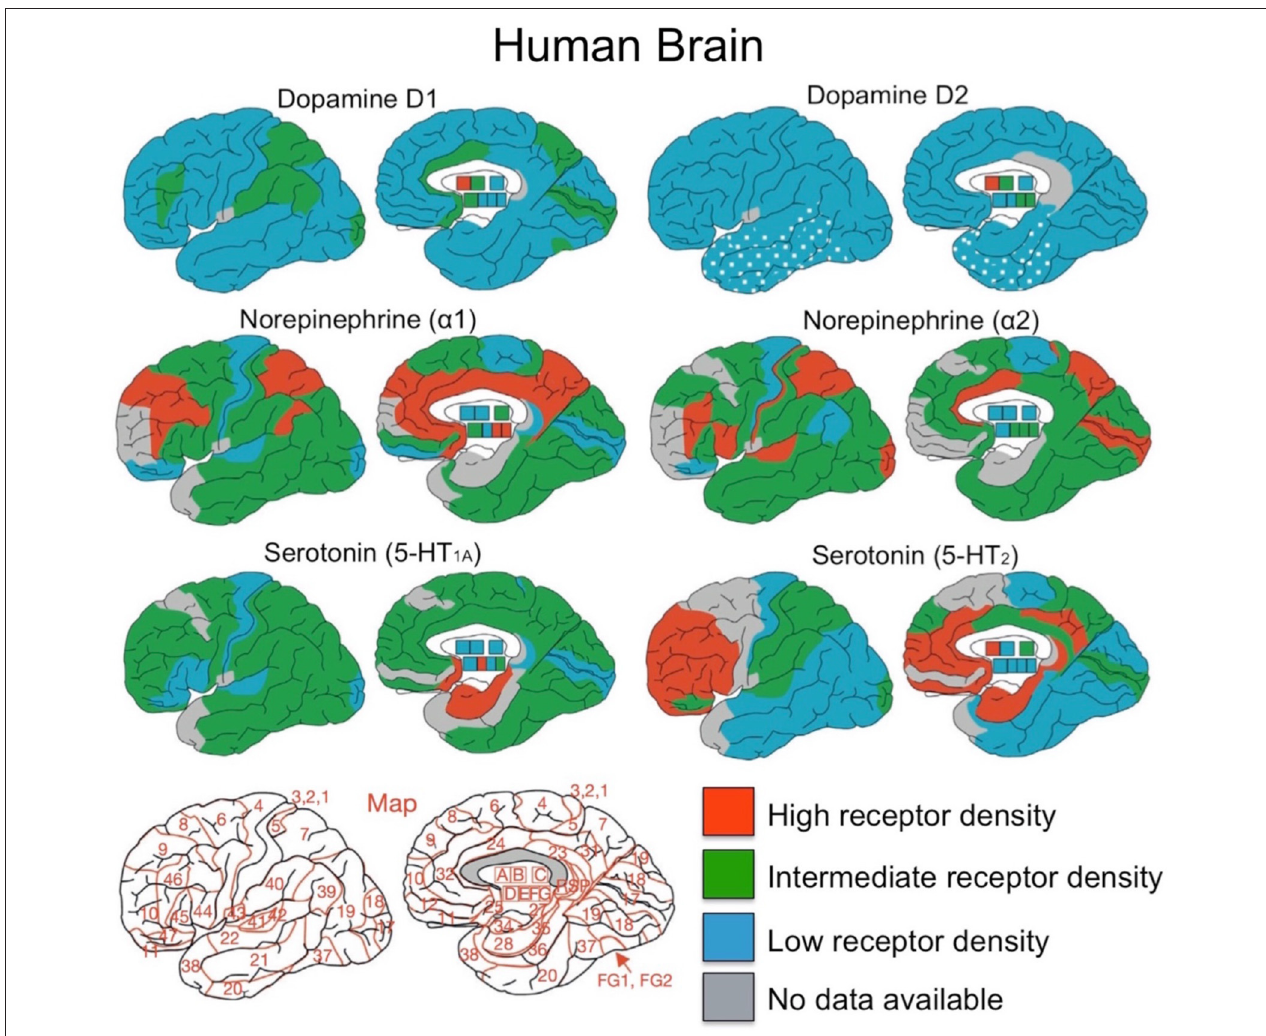
FIGURE 4 | Overview of distributions for dopamine, norepinephrine and serotonin receptors. Brodmann area map is presented in bottom left corner. A, caudate-putamen; B, globus pallidus; C, diencephalon; D, amygdala; E, CA1 region of hippocampus; F, CA2/3 region of hippocampus; G, dentate gyrus. Figure adapted from Palomero et al. (2015) with permission from Elsevier